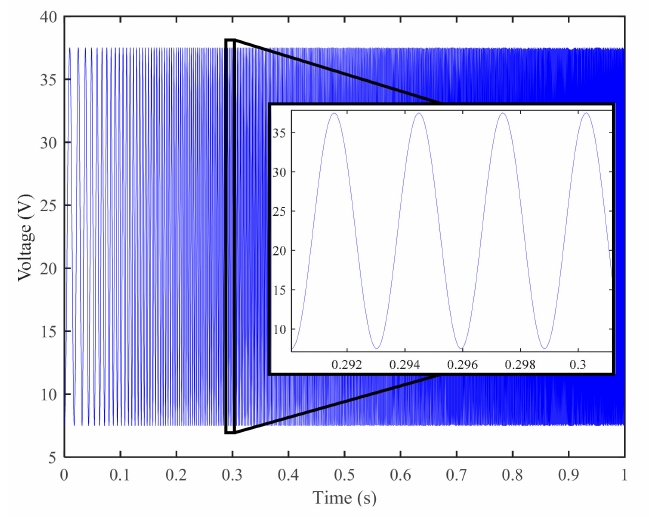
Figure 2. Driven signal for